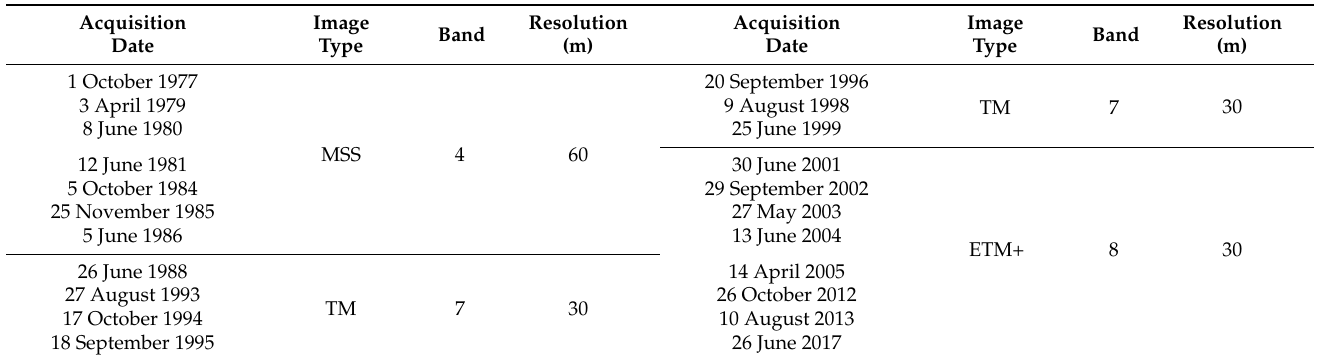
Table 1. List of remote sensing images of the Yellow River Delta.